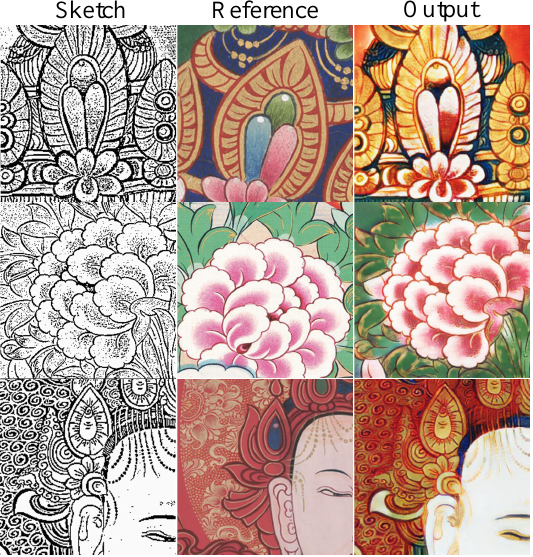
Figure 6. More colorization examples of Thangka sketches generated by our method. Our MACF-SCA generates visually excellent and semantically sound colorization result maps.